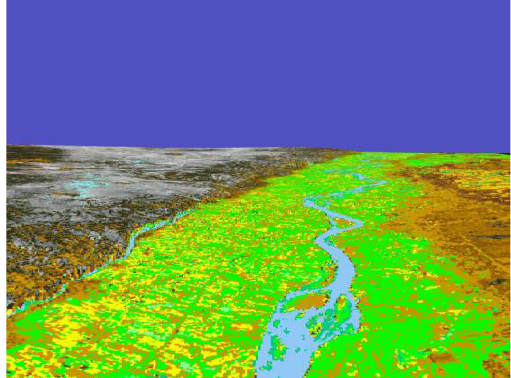
Figure 5. A landscape model showing the Euphrates river valley and Jebel Bishri in Syria produced by fusing X-SAR shuttle mission 2000 DEM data with Landsat-7 ETM image data.